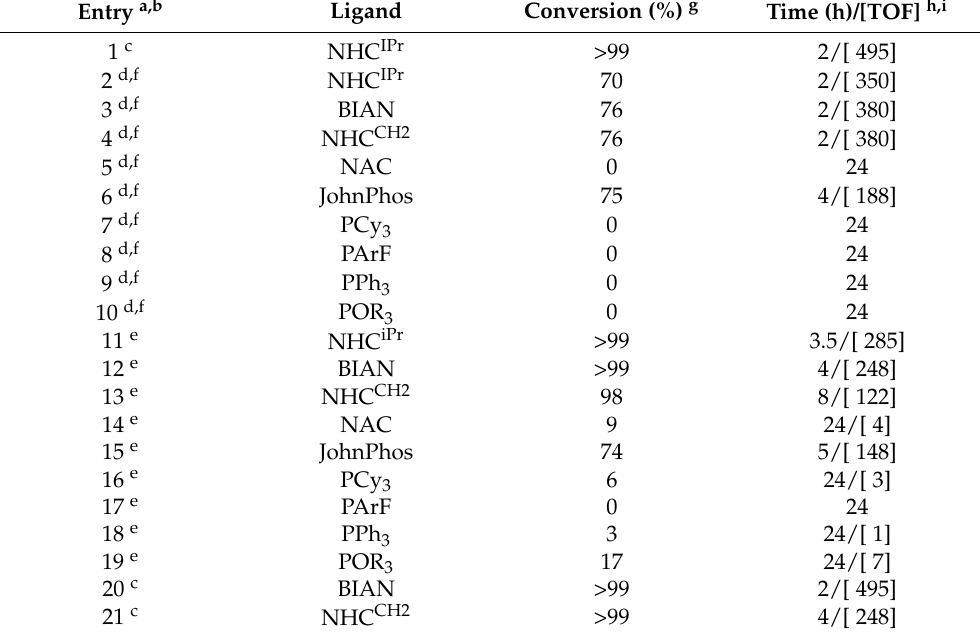
Table 19 . L–Au–X (0.1 mol%) catalyzed hydration of 3-hexyne at 30 °C in the presence of NBu 4 OTf .